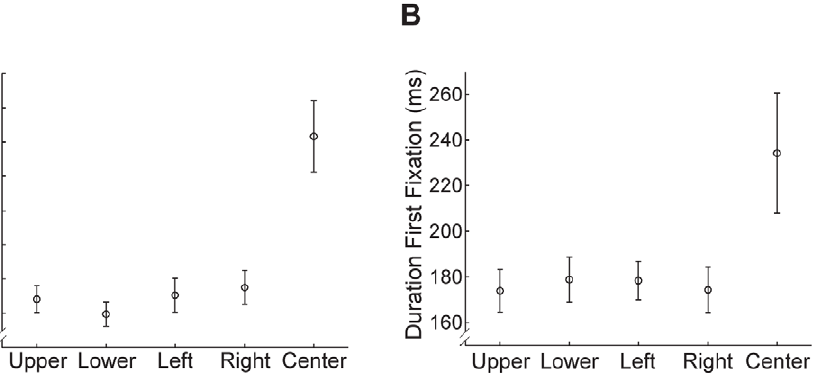
Figure 8. Impact of start position on timing of initial saccades and fixations for inverted faces. ( a ) Latency to first saccade. Note that the effect of start position was similar to that observed for upright faces with a longer latency for center compared to peripheral start positions (Figure 5a). ( b ) Duration of the first fixation. Again that the effect of start position was similar to that observed for upright faces with a longer fixation duration for center compared to peripheral start positions. All error bars indicate the between-subjects standard error.